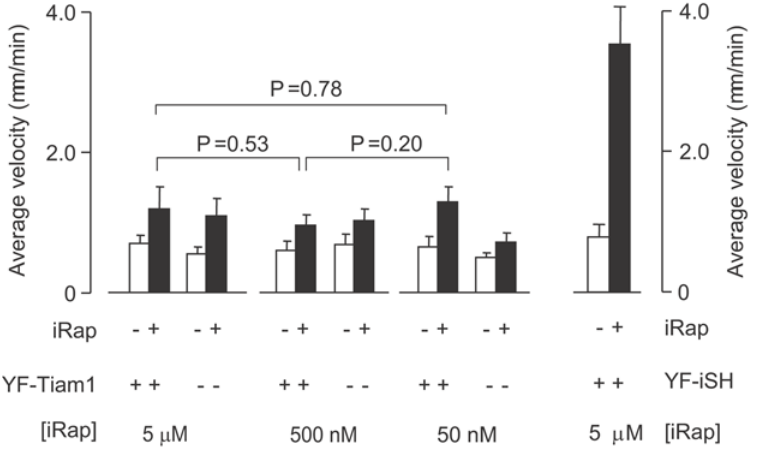
Figure 3. Control experiments show that neither maximal nor submaximal activation of endogenous Rac triggers cell polarization. Titration of the iRap concentration to determine whether submaximal Rac activation may trigger polarization and migration. Average velocities of Rac-activated cells was measured at different iRap doses (5 m M, 500 nM and 50 nM) before and after iRap addition. The right two bars show the average velocity of the PI3K-activated cells as a reference. Error bars are given as S.E.M. (n . 15 from more than three independent experiments).